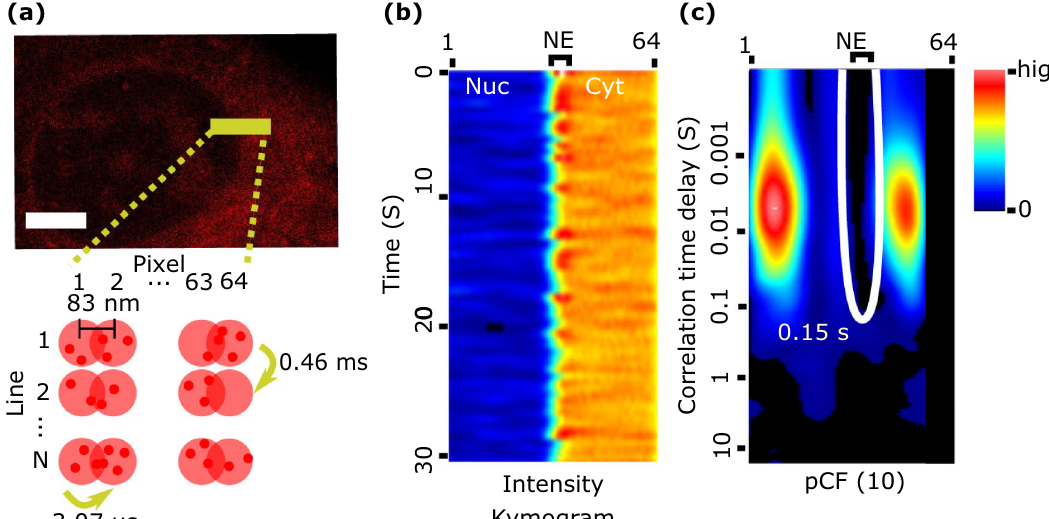
Figure 2. Schematic representation of the pCF analysis. A 64-pixels long line (corresponding to a distance of 5.3 μm) across NE is repeatedly scanned from left-to-right with a line time of 0.46 ms, a pixel dwell time of 3.07 μs, and a pixel size of 83 nm (resulting in an oversampling of the microscope’s PSF, pink circles). ( A ) A confocal image of an infected cell. Scale bar is 5 μm. ( B ) Fluorescence intensity along lines is collected and represented as a kymogram where pixels along the lines correspond to the horizontal axis while the time is in the vertical axis. The position of the NE is identified with a resolution of 200—300 nm (2–6 pixels depending on experimental pixel size) as it is diffraction limited. ( C ) The pair correlation function at a distance of 10 pixels (830 nm) is calculated pixel-by-pixel and represented with the pixel position in the horizontal axis and the time in logarithmic scale in the vertical axis. The white arch indicates a lengthening in the transport throughout the